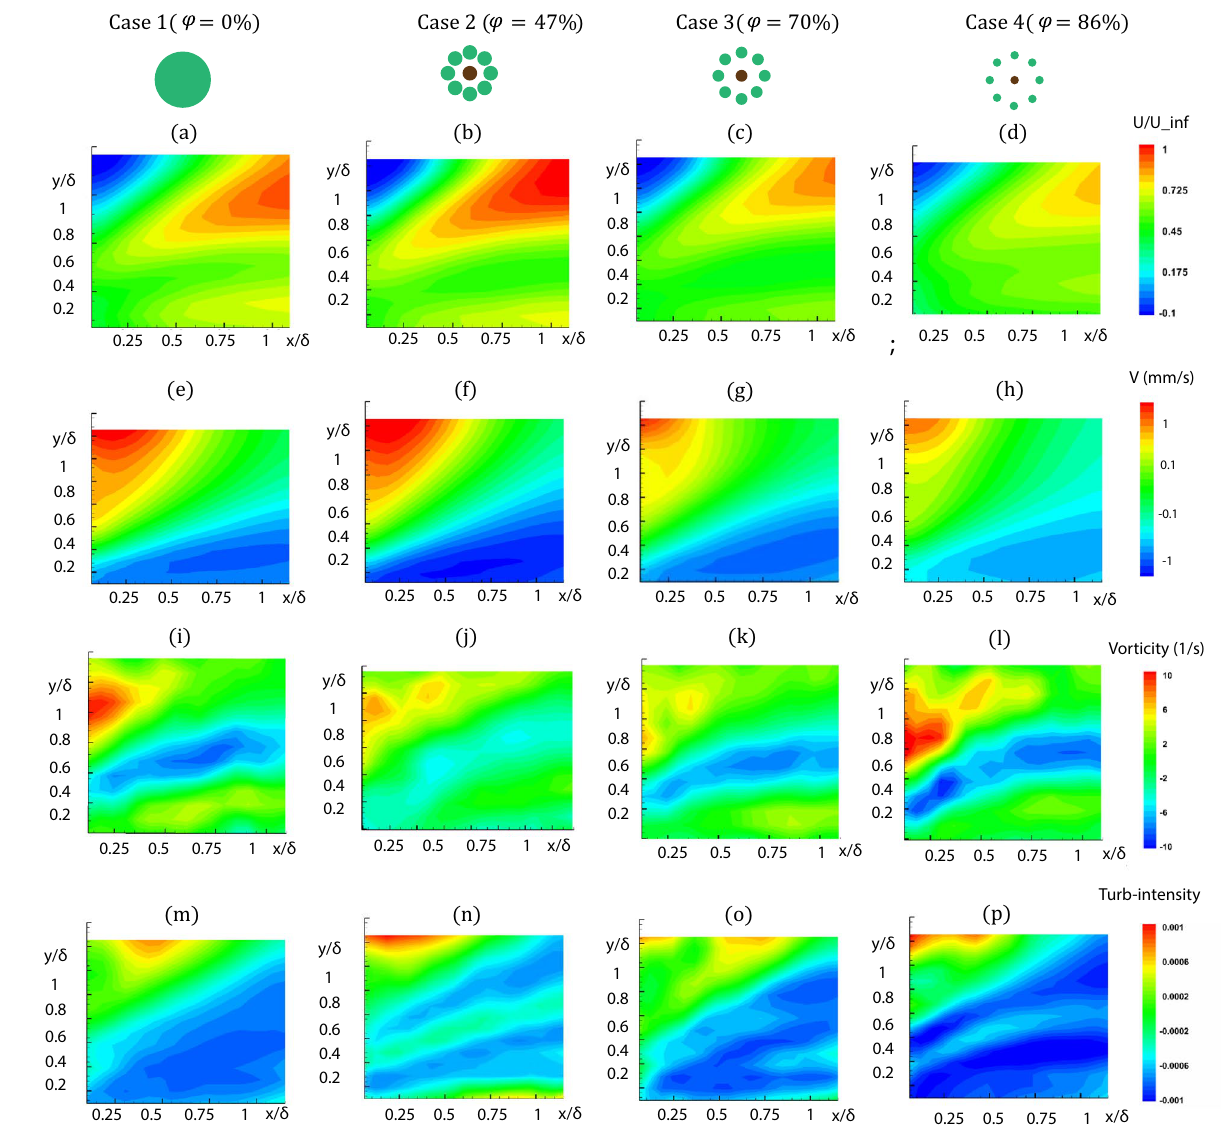
Figure 6. Time-average flow fields downstream of the patches for different porosities. Left column: case 1, φ 1 = 0% ; Second column: case 2, φ 2 = 47% ; and second from right column: case 3, φ 3 = 70% ; Right column: case 4, φ 4 = 86% ; ( a )–( d ) Streamwise velocity; ( e )–( h ) contour of velocity in the Y direction. ( i )–( l ) contour of vorticity; ( m )–( p ) contour of turbulence intensity (TI). All results are at Re = 2500 with time step t = 0.008 s and form time period of T = 8 s.